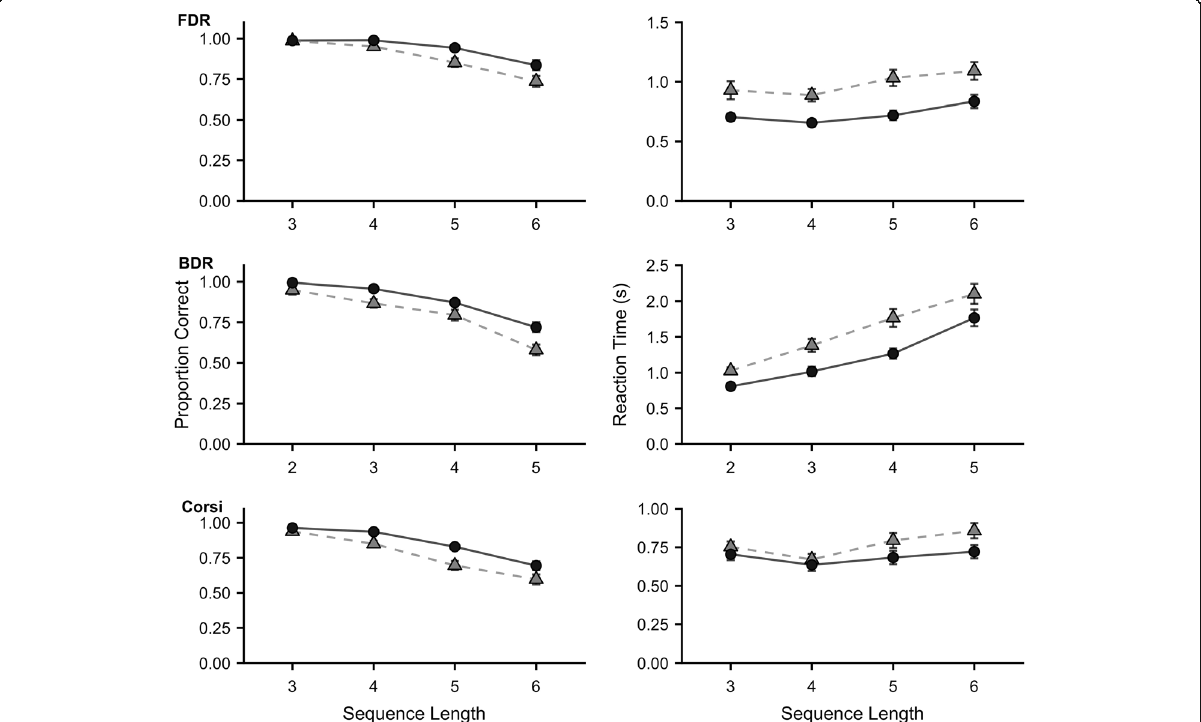
Fig. 3 Forward Digit Recall (FDR); Backward Digit Recall (BDR); Corsi Block Tapping. Mean proportion correct (column 1) and mean reaction time (column 2) for both groups (Control = circles, TN = triangles) across all sequence